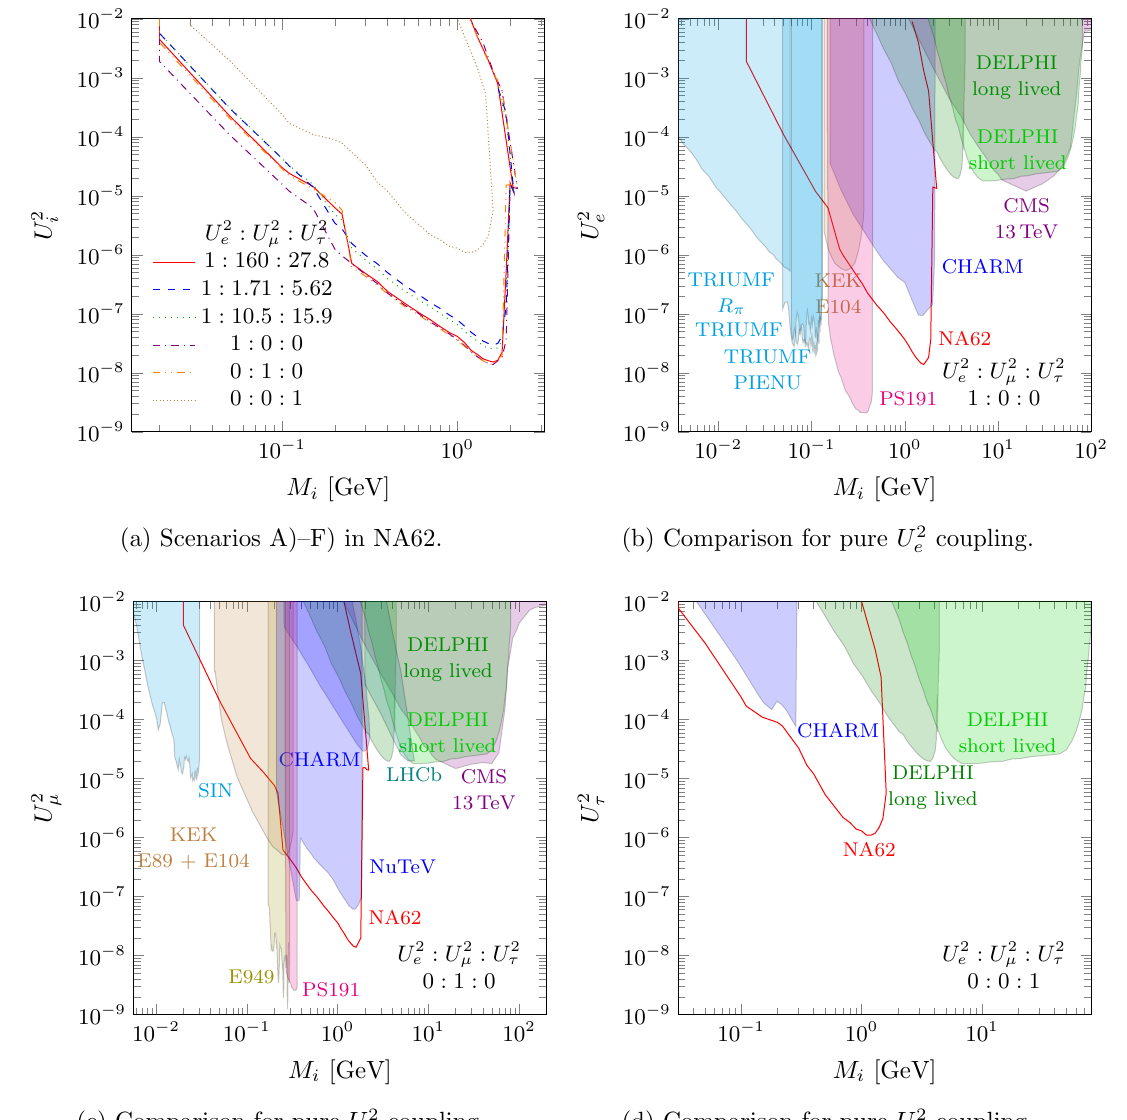
Figure 7. Sensitivity of the NA62 experiment in the scenarios A){F) in Panel (a). The region above the curves marks the expected exclusion regions for 2.3 events for each scenario. For the three extreme cases D), E) and F) we compare our results with current exclusion limits in the Panels (b), (c) and (d), respectively. The strongest bounds come from SIN [97], TRIUMF [45, 46, 98], KEK